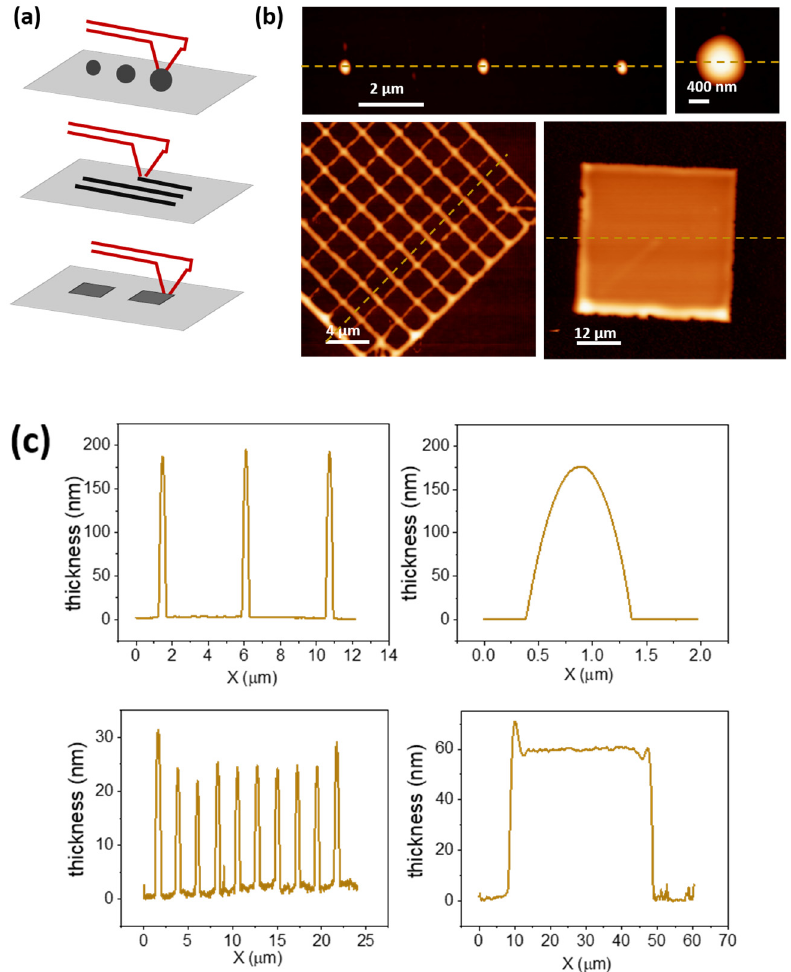
Figure 2. Basic geometrical patterns obtained with pure adhesive, Loctite. ( a ) Scheme of printing dots, lines, and squares as basic geometric patterns. ( b ) AFM topography images of exemplary printed structures and ( c ) corresponding profile sections of the structures at the yellow dashed line in ( b ).